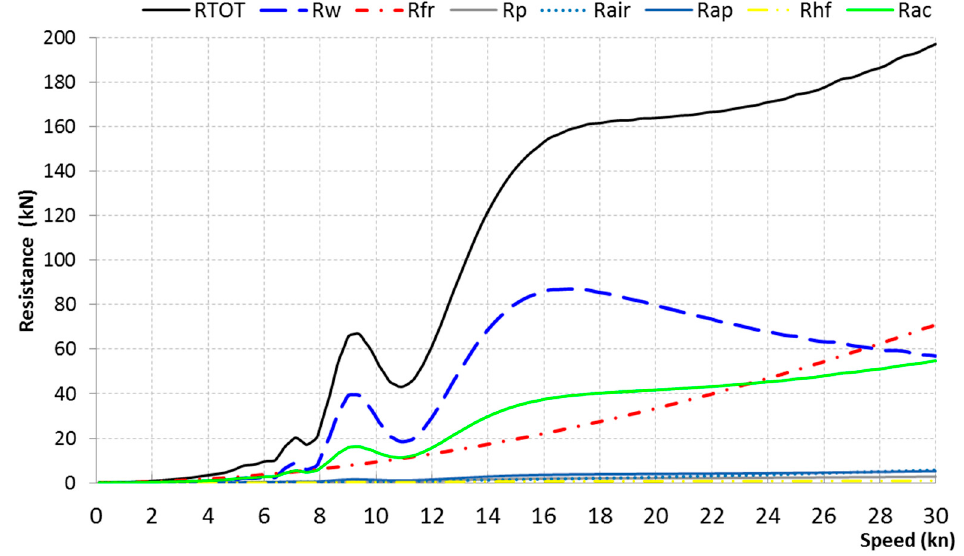
Figure 4. Resistance related to a moving SWATH II vessel.